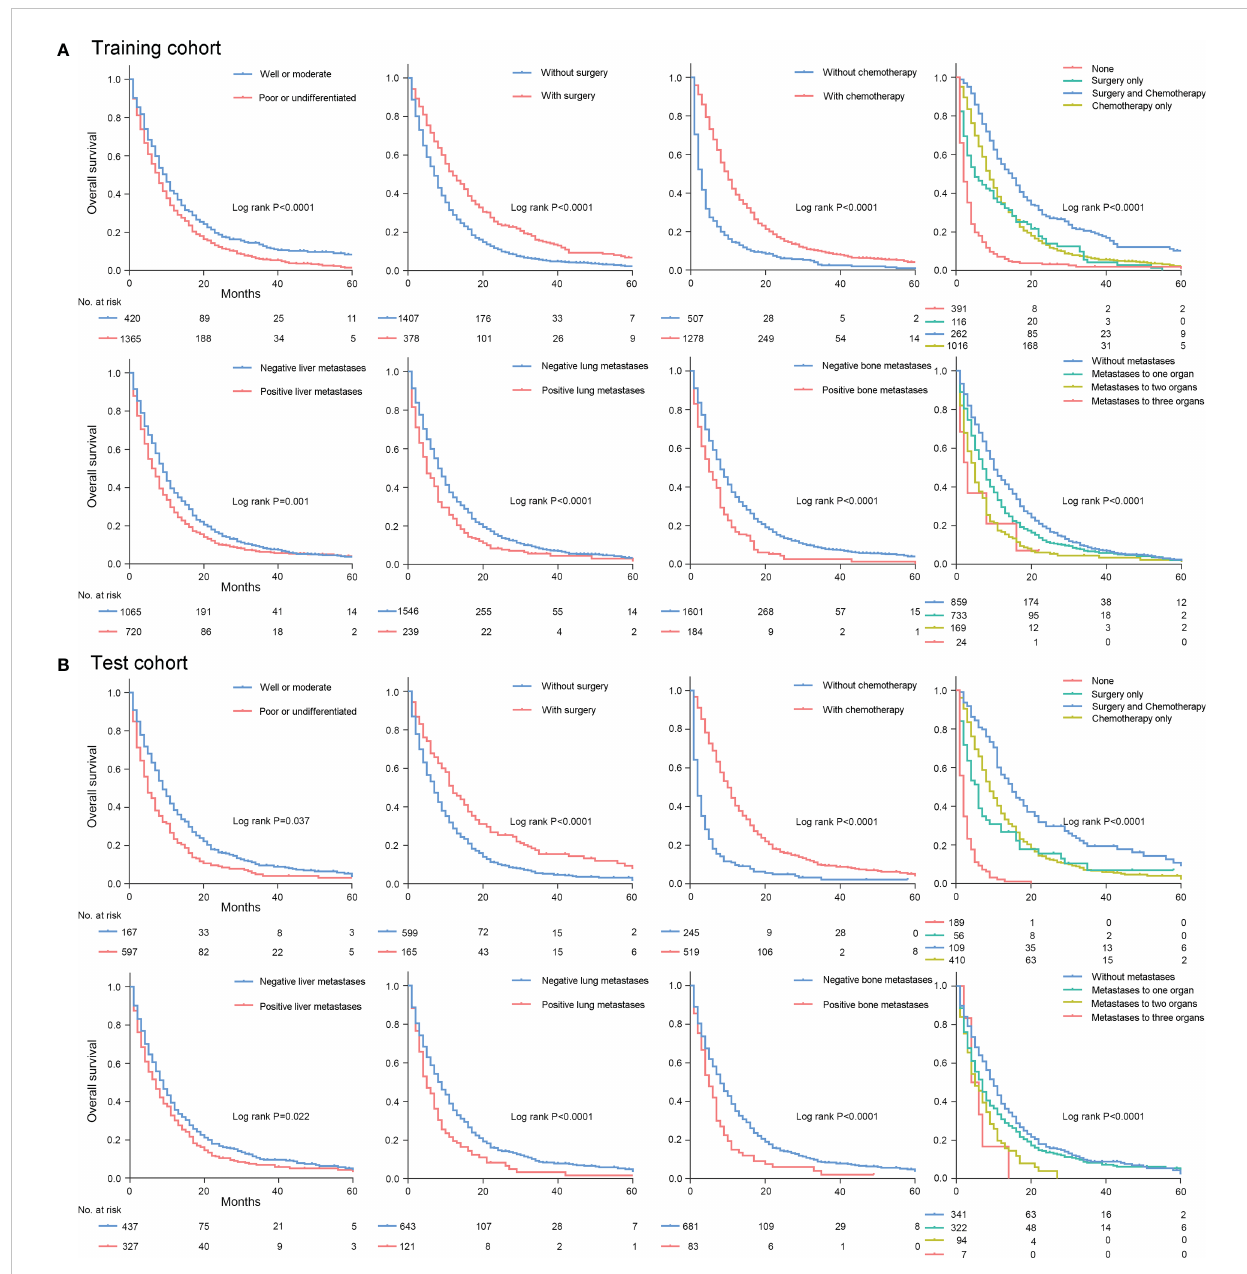
FIGURE 2 Kaplan-Meier plots for overall survival in the training cohort (A) and test cohort (B)